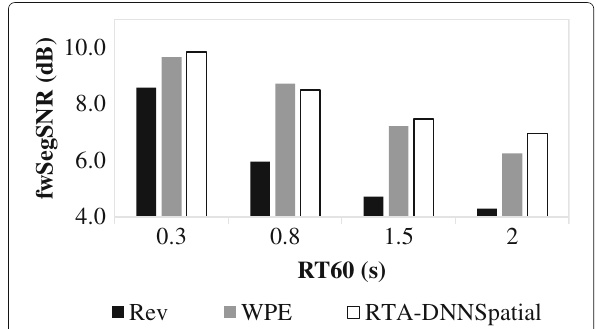
Fig. 12 Average fwSegSNR results at different RT60s, tested at a new loudspeaker position